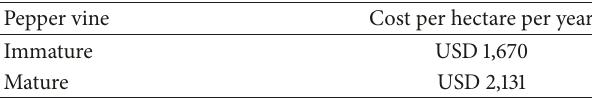
Table 1: Cost of fertilization associated with pepper